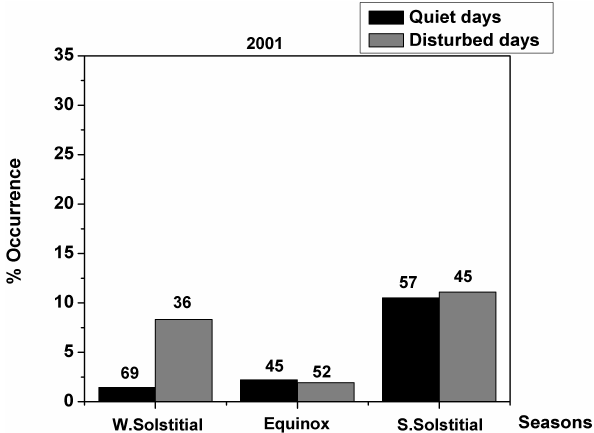
Fig. 3a. Seasonal variation in the F3 layer occurrence during quiet and disturbed days of the solar maximum year of 2001. The total number of days on which ionogram data was available during each season is shown in the top of the histogram.